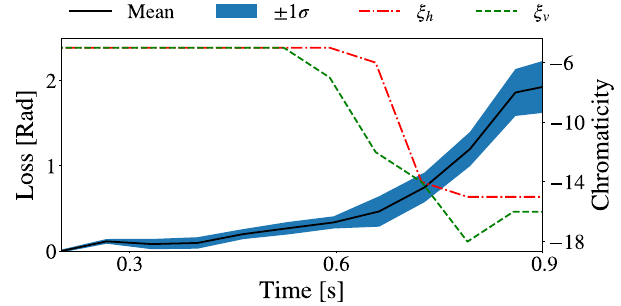
FIG. 5. An example of how the total loss sum increase with chromaticity before the installation of the diode damper. The black line shows the average of 100 pulses along a blue band showing one standard deviation from this mean.